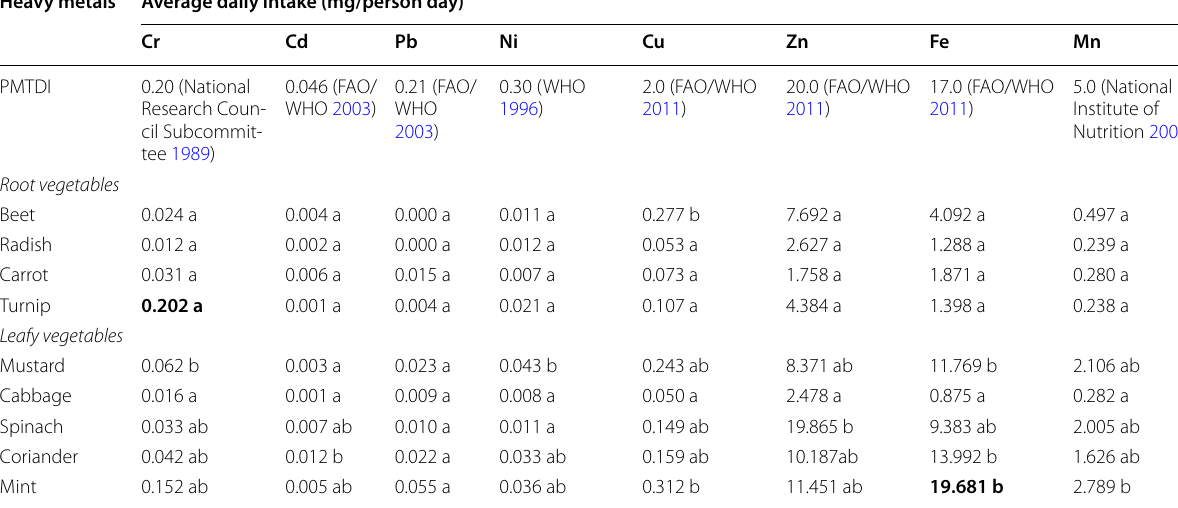
*DMRT analysis has been performed separately for root and leafy vegetables. Mean values with the same letter(s) in a column of root and leafy vegetables state no significant difference from each other at 5% level by DMRT within the root or leafy vegetables